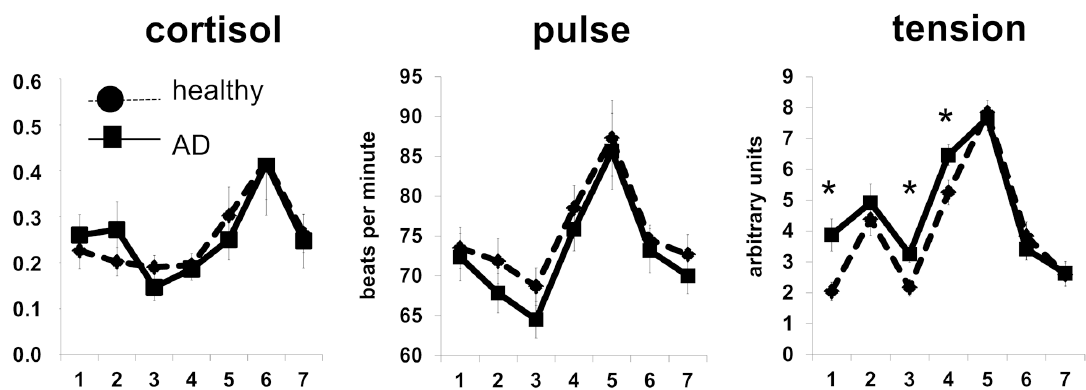
Figure 3. Stress response during TSST. During TSST salivary cortisol levels (HPA), pulse (beats per min, SA) and tension assessment (Likert scale, psychoemotional stress perception) were obtained 7 times. Time points: 1 5 after rest before biopsy, 2 5 immediately after biopsy, 3 5 30 min after